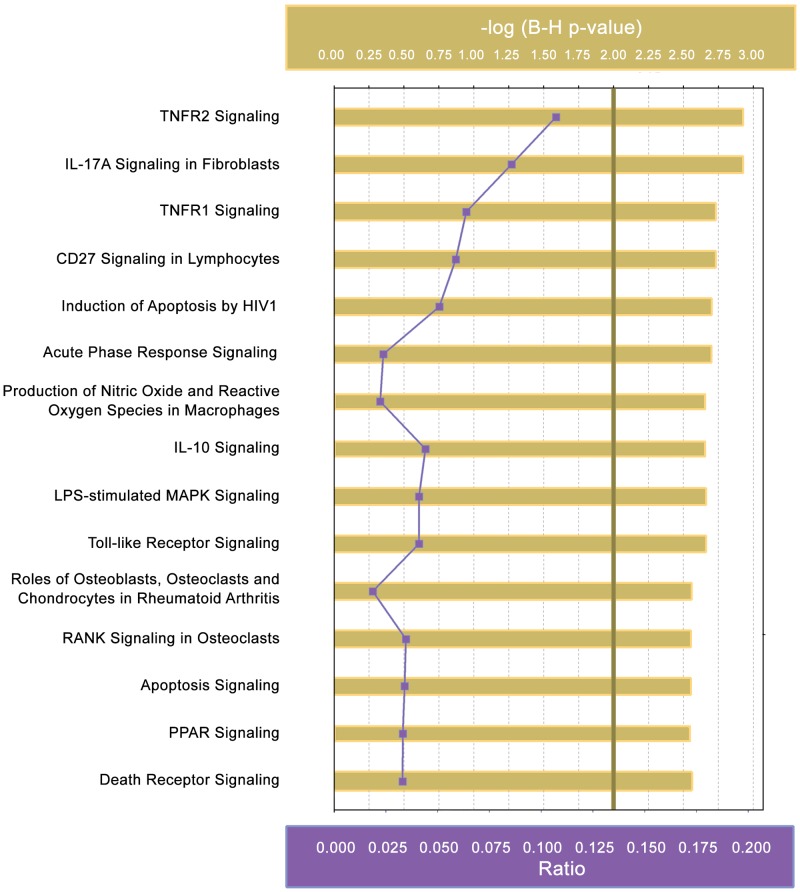
Canonical pathways represented by the differentially expressed genes following incubation of primary mesothelial cells with S. epidermidis for 1 hour.28 differentially expressed genes identified by microarray following incubation of S. epidermidis with primary mesothelial cells were analysed using Ingenuity Pathway Analysis (IPA) and 35 canonical pathways were represented in our dataset. The top 15 canonical pathways are shown above, with the full list of canonical pathways shown in S1 Table. A -log(B-H p-value) (shown in gold) of >2 represents data with an adjusted p-value < 0.01 (threshold for significance shown as a vertical line at 2.00). The ratio (shown in purple) indicates the proportion of differentially expressed genes relative to the total number of genes in each pathway.